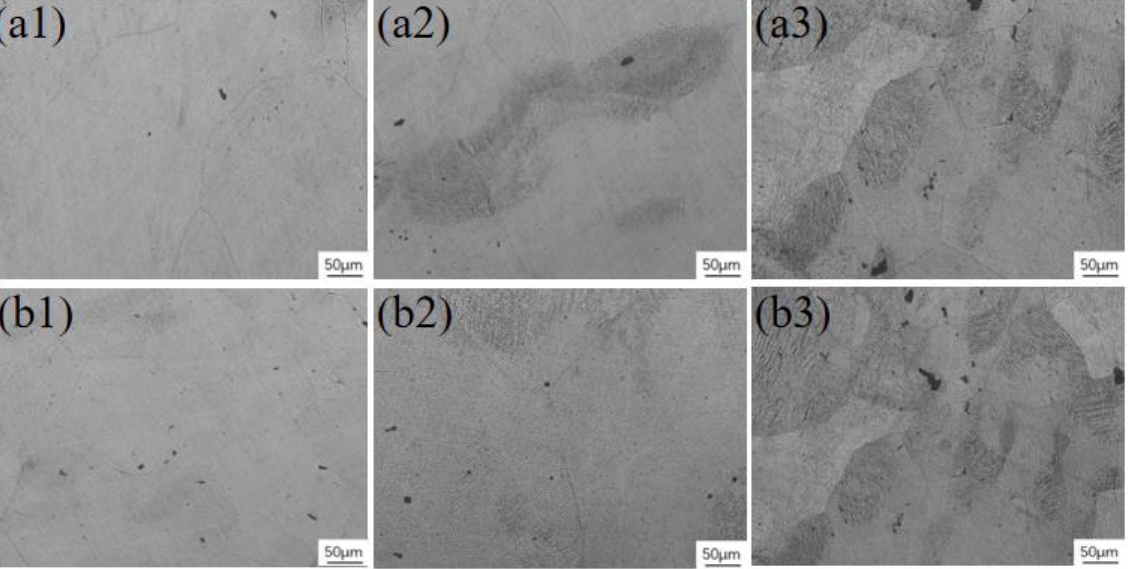
Figure 3. Metallographic microstructure of TNZ-xCu samples; ( a1 ) TNZ-3Cu(T4); ( a2 ) TNZ-3Cu(T6- 30m); ( a3 ) TNZ-3Cu(T6-2h); ( b1 ) TNZ-7Cu(T4); ( b2 ) TNZ-7Cu(T6-30m); ( b3 ) TNZ-7Cu(T6-2h). Figure 4 reveals the SEM microstructure of the alloys under different aging time.